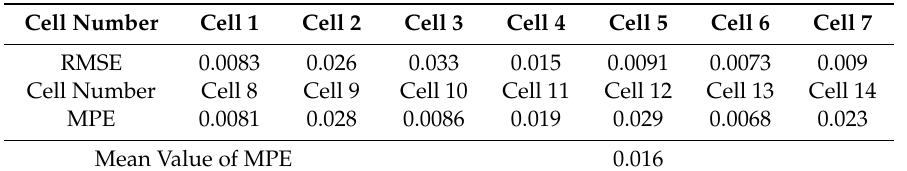
Table 3. MPE of state jump observer.